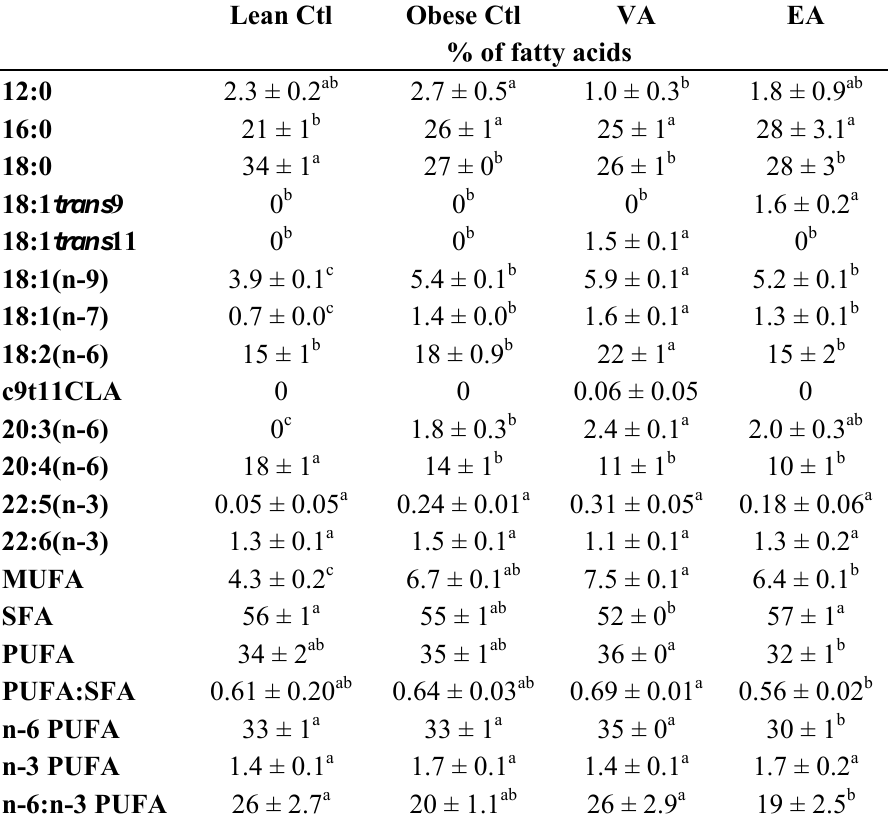
Table 1. Plasma PL fatty acid concentrations in lean rats and obese JCR:LA- cp rats fed Ctl, VA or EA diets. Lean Ctl Obese Ctl VA